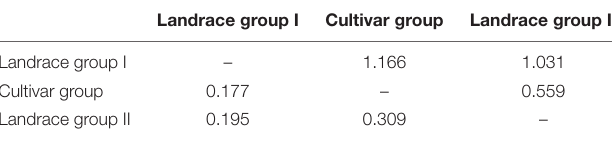
TABLE 3 | Gene flow (Nm, upper right diagonal) and pairwise genetic differentiation (F st , down left diagonal) among the two Iranian wheat landrace groups and the cultivar group grouped by structure